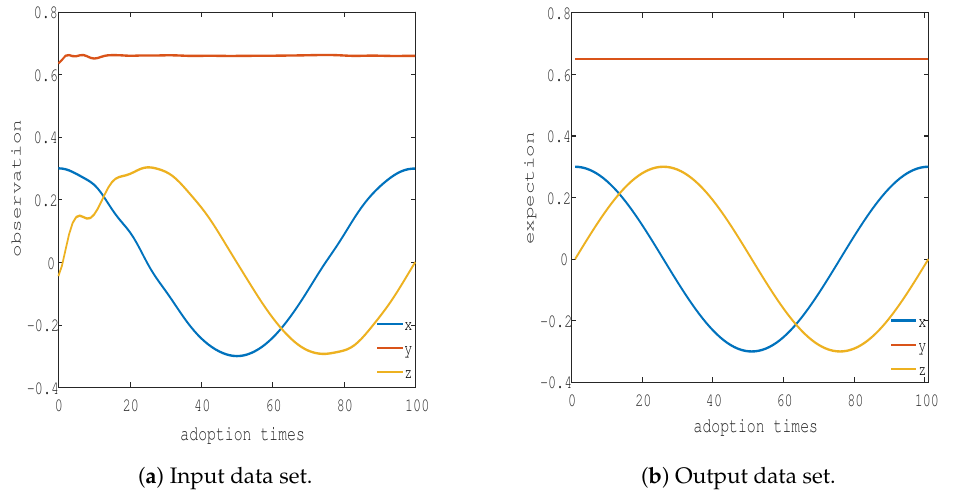
Figure 10. Input and output data set.